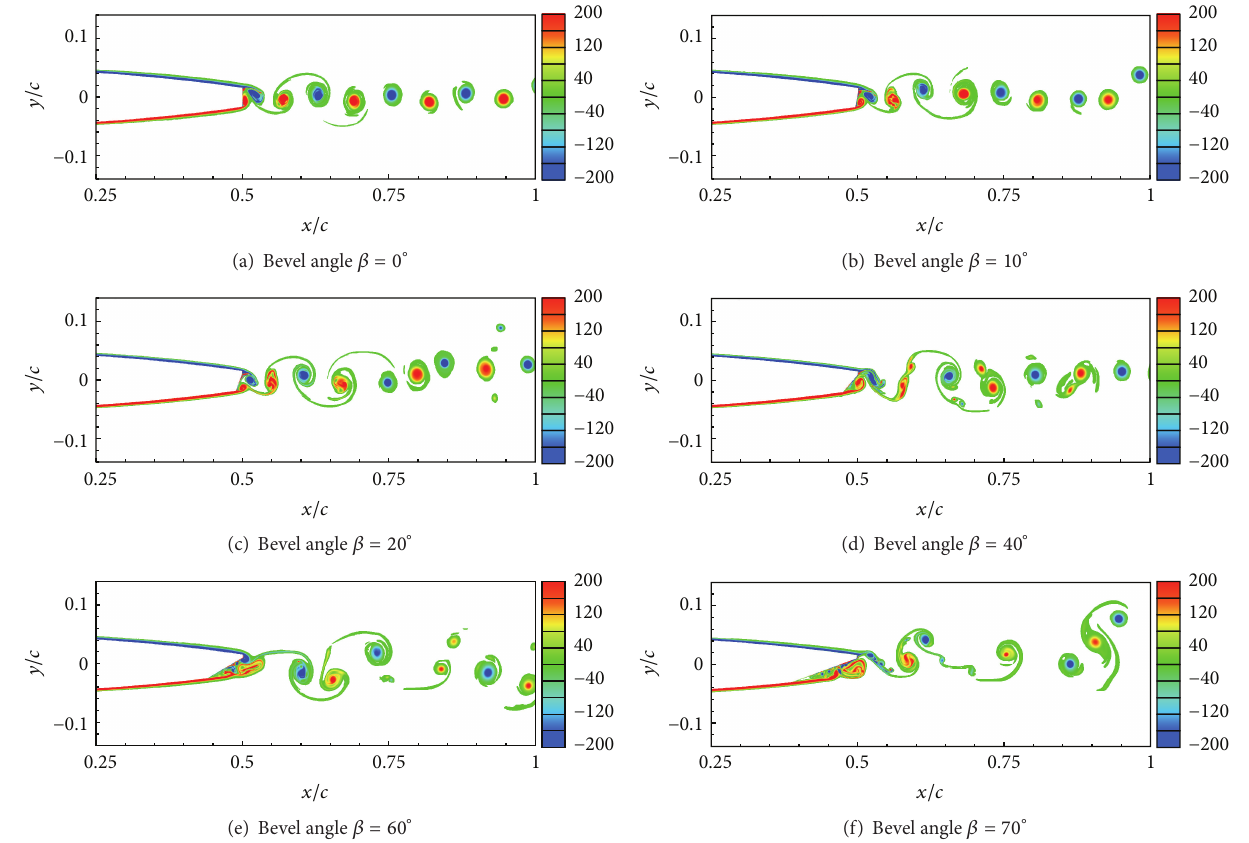
Figure 5: Instantaneous vorticity distributions at 𝑇 = 10 for Re = 10 6